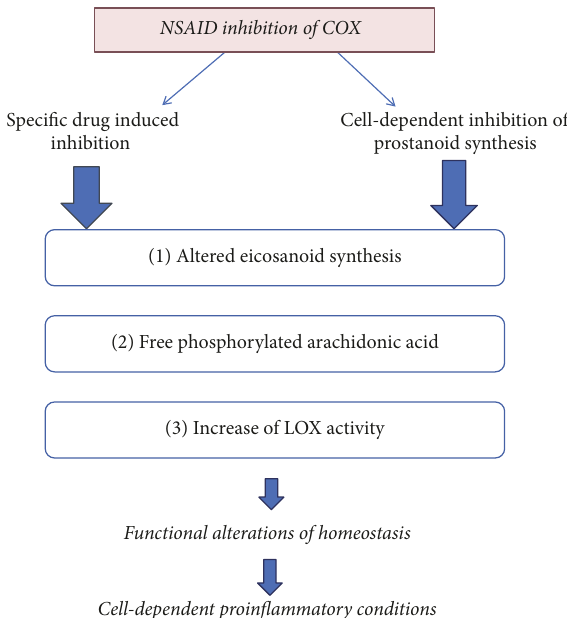
Figure 1: Levels of possible side effects of NSAIDs [18]. Drug- and cell-specific inhibition of COX isoenzymes [15] and respective prostanoidsresultsinalterationofhomeostasis[7]andinpromotion of proinflammatory conditions